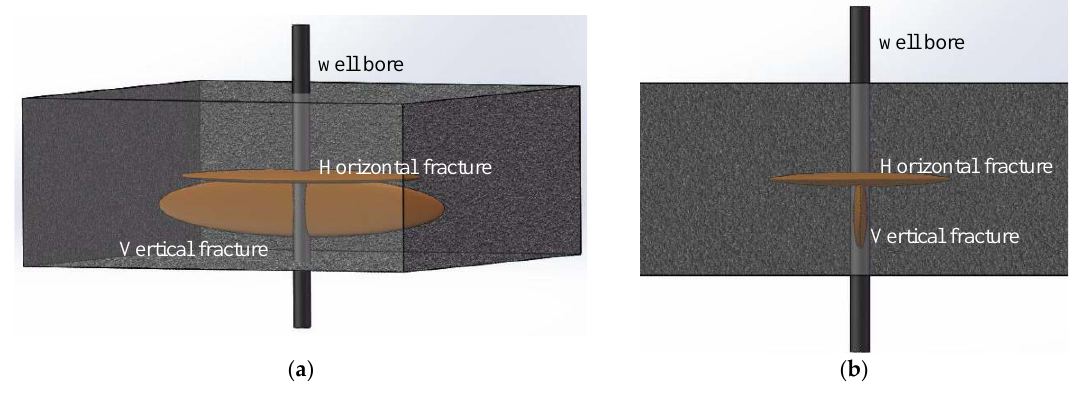
Figure 1. T-type fracture in coal: ( a ) Front view; ( b ) Side view [13].